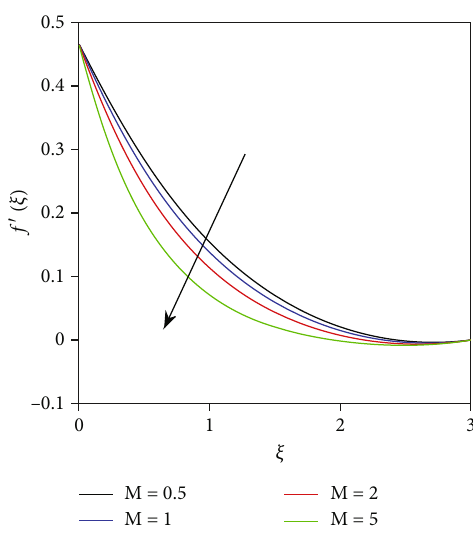
Figure 2: Radial velocity pro fi les for magnetic fi eld parameter M .